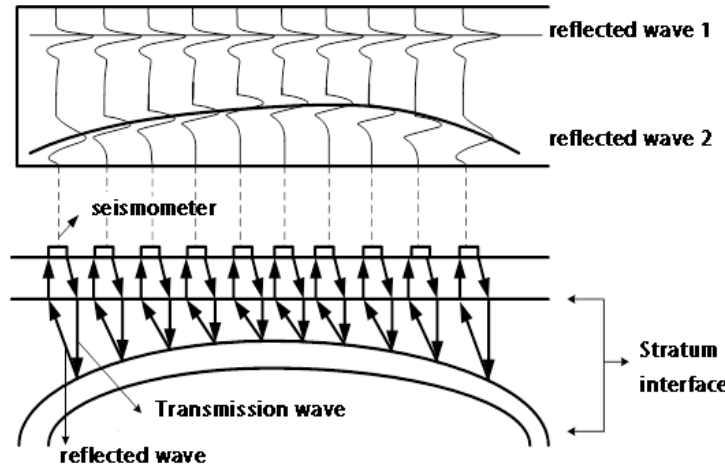
Figure 8. Flow chart of seismic signal acquisition.